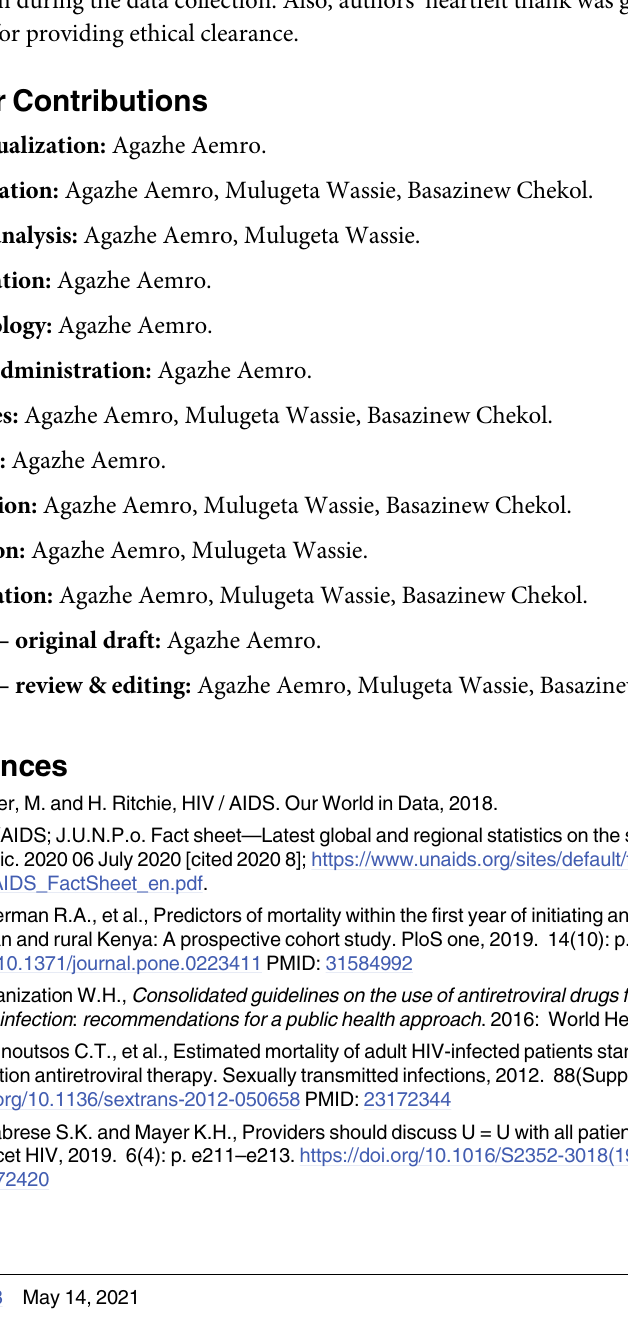
S1 Table. Bi-variable Cox regression analysis of predictors of mortality within one year of ART initiation among adults on ART at Debre-Markos Referral Hospital; Jan 1, 2014 to Dec 31, 2018 (n =